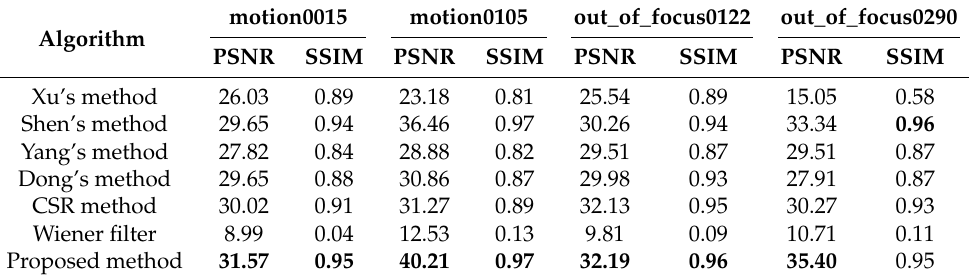
Table 1. Quantitative comparison by peak signal-to-noise ratio (PSNR) and structural similarity index (SSIM) evaluation